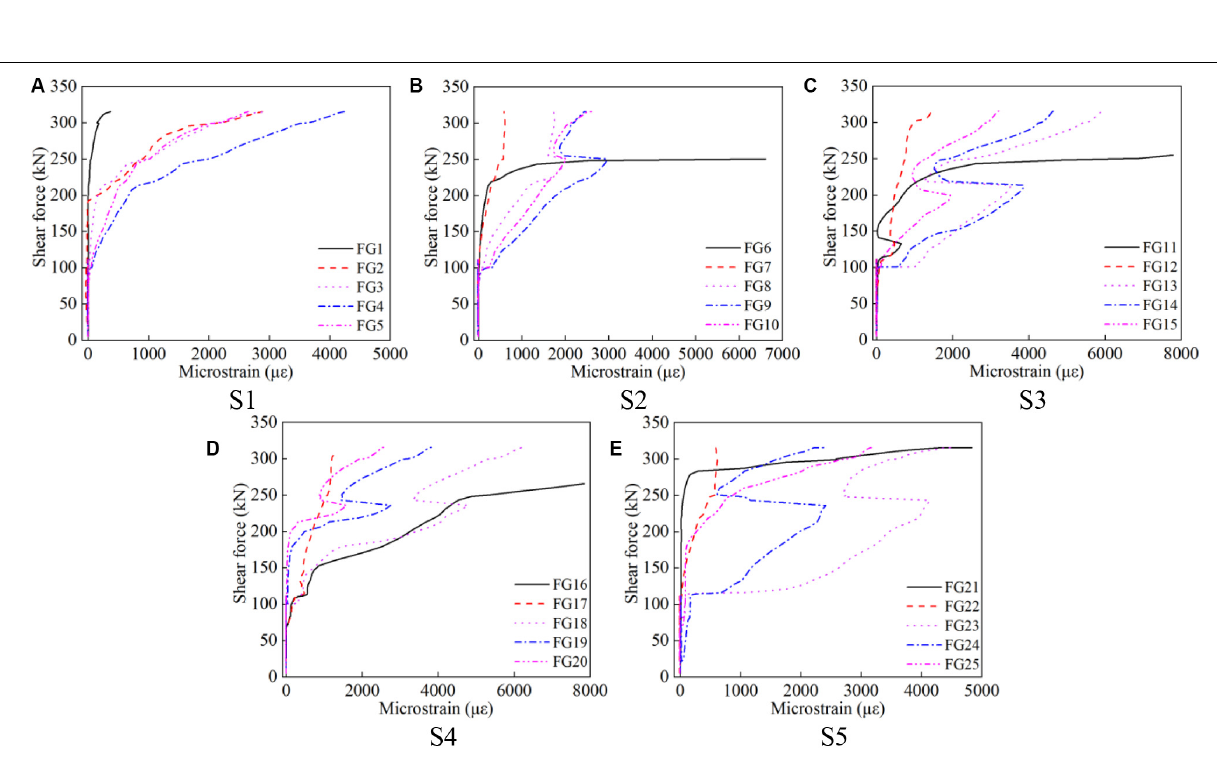
Frontiers in Materials |